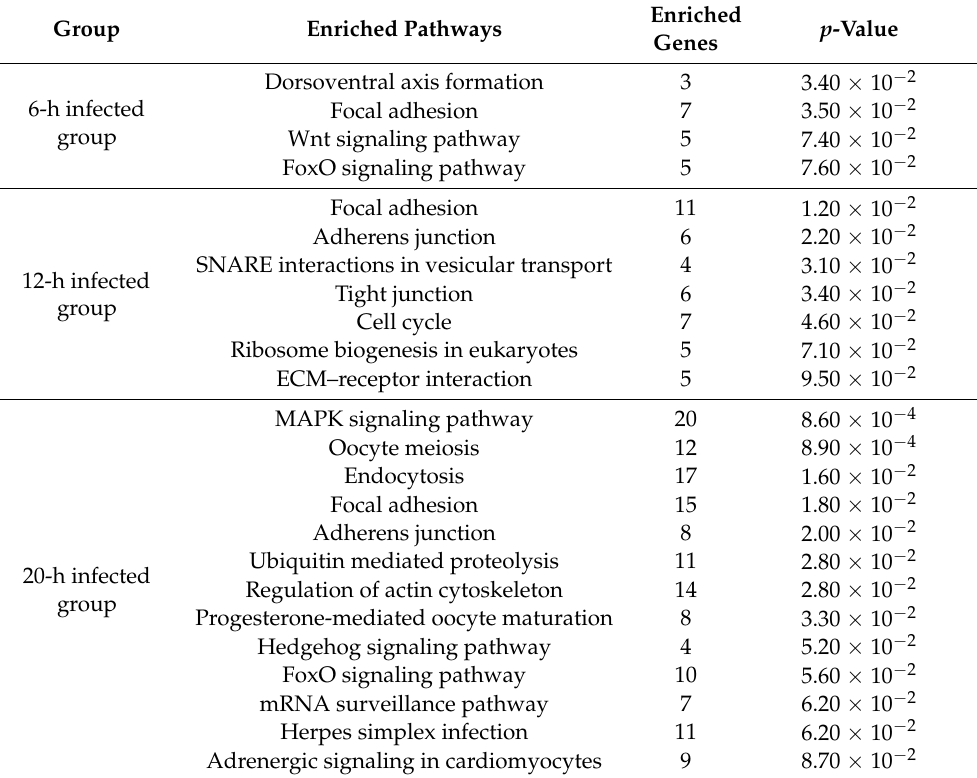
Table 2. KEGG pathway enrichments of the parental genes of the circRNAs differentially expressed during H5N1